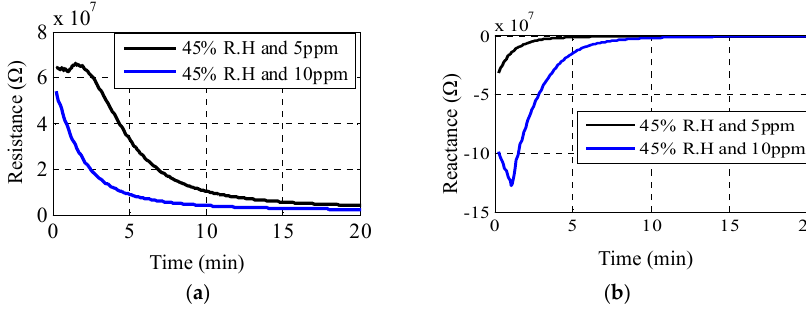
Figure 11. Change in ( a ) real impedance; and ( b ) reactance of sensor exposed to 5 ppm and 10 ppm concentrations of H 2 S at a relative humidity of 45% and measured at 2 MHz.